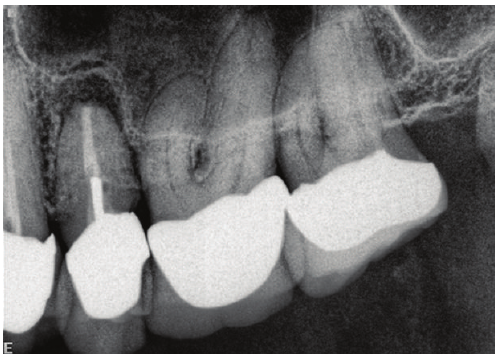
Figure 1: Intraoral periapical radiograph of second premolar tooth used in the